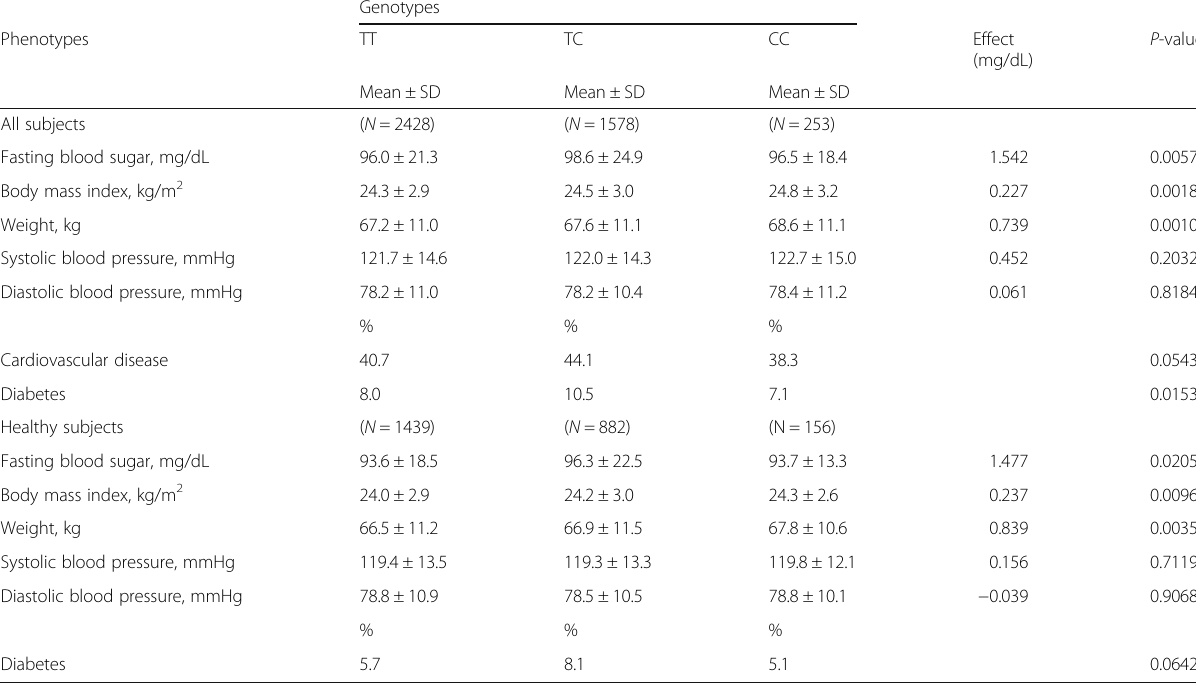
Table 2 Association between the rs17782313 single nucleotide polymorphism in the MC4R gene and fasting blood-sugar levels based on a linear regression model